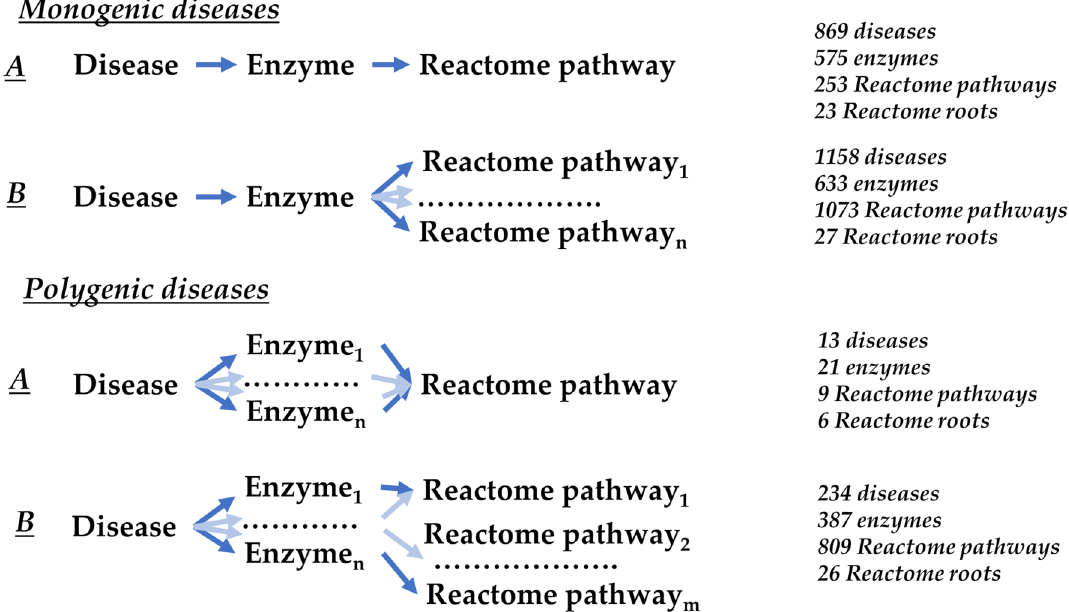
Figure 3. Relations among diseases and Reactome pathways, as mediated by the enzymes included in DAR. The total number of diseases is 2539. 178 Enzymes out of 1494 lack Reactome annotation. Therefore, 265 diseases (248 monogenic and 17 polygenic) are excluded from the